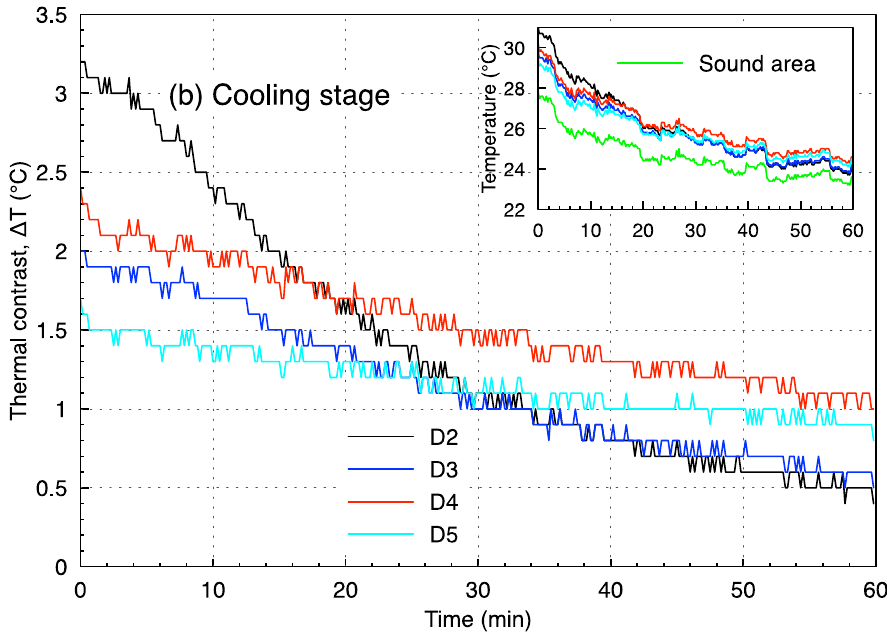
Figure 14. The thermal contrast evolution of a thermal image sequence during the infrared thermog- raphy (IRT) test for the concrete specimen with defects D2–D5, during the ( a ) heating and ( b ) cooling stages. The insets show the surface temperatures of the defective and sound concrete zones. The same line colors were used in the insets as in the original legend.